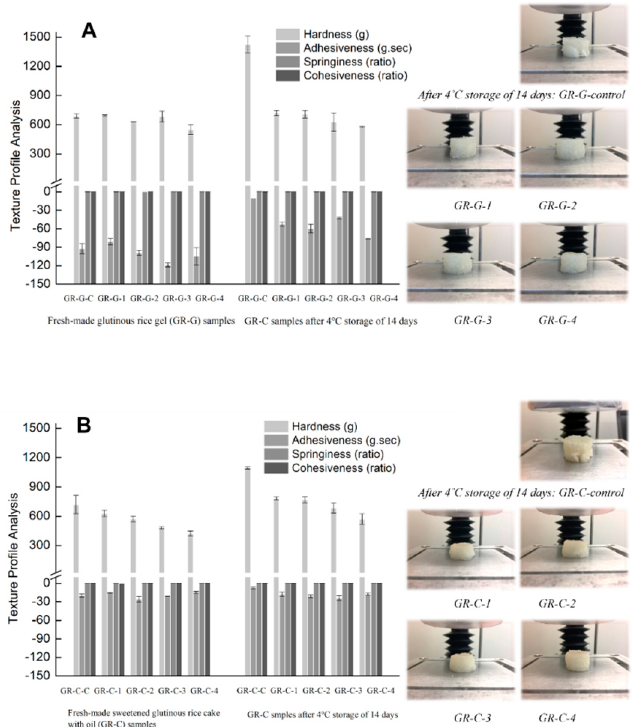
Figure 3. Textural properties of the freshly cooked and 14-day stored at 4 ◦ C glutinous rice gel (GR-G) samples ( A ) and sweetened glutinous rice cake (GR-C) samples ( B ), and visual images of the stored GR-G and GR-C samples after TPA testing. The GR-G and GR-C samples were prepared using rice grains without PEF treatment (GR-G-control, GR-C-control), and with 100 (GR-G-1, GR-C-1), 200 (GR-G-2, GR-C-2), 300 (GR-G-3, GR-C-3), and 400 (GR-G-4, GR-C-4) pulses of PEF treatment. Each plotted point represented the average of five trials ± SD.